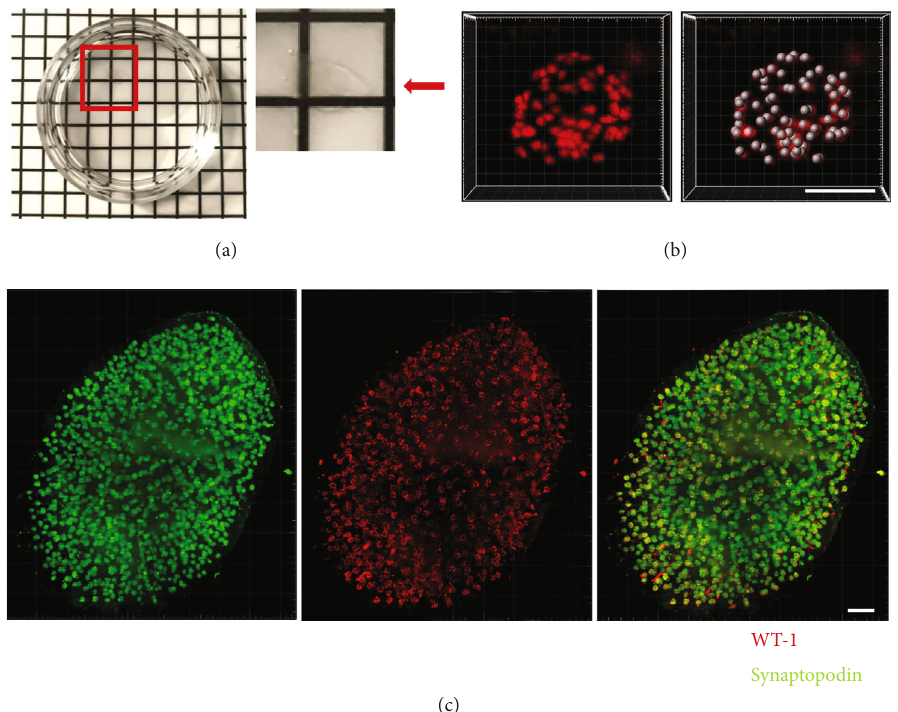
Figure 1: Optical clearing, light-sheet microscope, and 3D rendering for whole glomeruli. (a) 2mm thick kidney tissue from C57 mice was analyzed by optical clearing using CUBIC method. Red arrow displayed the location of the translucent tissue. (b) Double immuno fl uorescence staining with podocyte cytoplasmic marker synaptopodin (green) and podocyte nuclear marker WT-1 (red) identi fi ed glomeruli and podocytes with light-sheet microscope by using the CUBIC method (screenshots from three-dimensional video). (c) Podocyte nuclei stained with WT-1 (red) of a single whole glomerulus and the linked 3D reconstruction image are shown, which depicted the practicality of counting podocyte number with the CUBIC method. Shown are representative images from fi ve C57 mice with similar results (scale bar: 50 μ m in all images of (b); 400 μ m in all images of